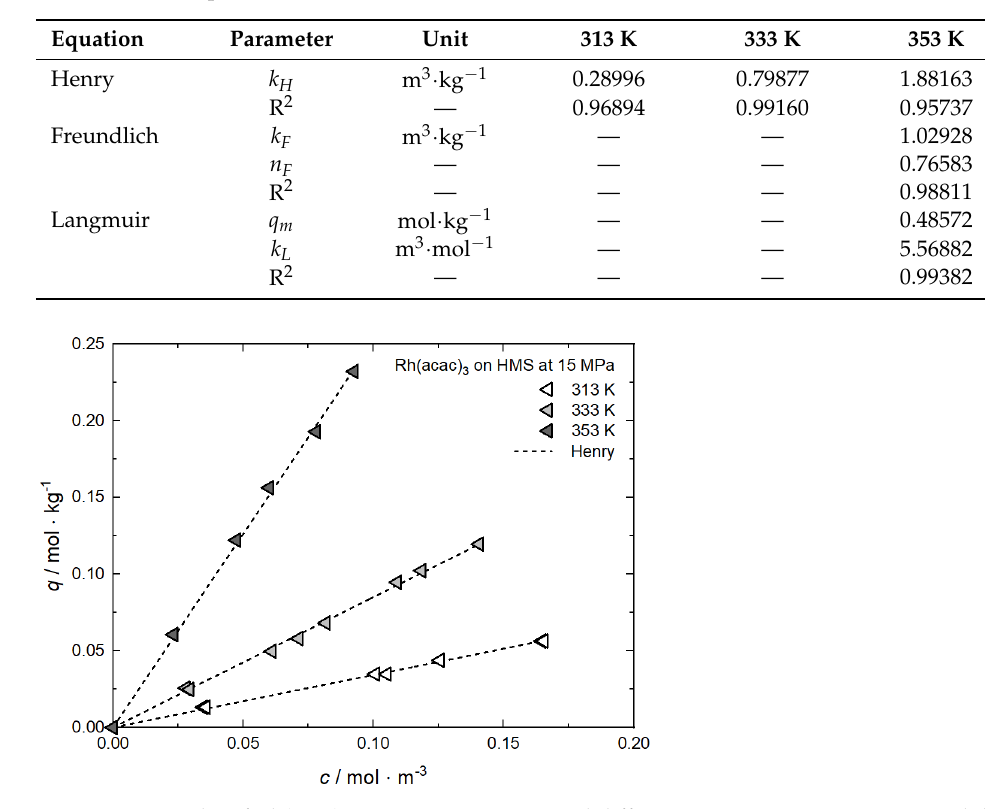
Figure A6. Uptake of Rh(acac) 3 on MSU-H at 15 MPa and different temperatures; experimental data taken from [62]. Table A6. Adsorption isotherm parameters for Rh(acac) 3 from scCO 2 solution on MSU-H at 15 MPa and different temperatures [62].